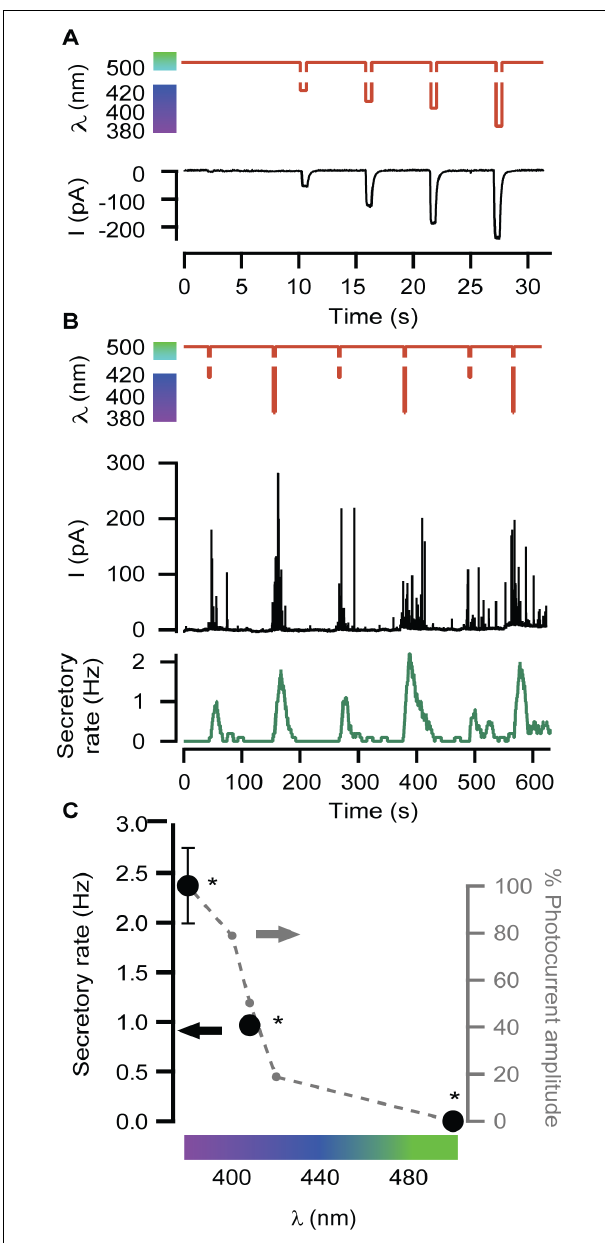
FIGURE 2 | Modulation of secretory rate. (A) LiGluR current amplitude can be adjusted with the illumination wavelength: whole-cell patch clamp current responses (black) to light pulses between 500 nm and different UV wavelengths (sequence of pulses of 420, 408, 400, and 380 nm, red plot). (B) The wavelength of light stimuli (red plot) allows adjusting the size of the burst of amperometric spikes (black plot) and thus the maximum secretory rate in each burst (green plot).The exocytosis rate always returns to 0 under 500 nm light, and can be driven reproducibly at 1 or 2 Hz by stepping to 408 or 380 nm, respectively. (C) Plot of the averaged secretory rate in • , left y -axis, N = 4 cells) response to 380, 408, and 500 nm light ( measured by amperometry. In gray, photocurrent amplitude dependence on wavelength illumination in LiGluR( + ) chromaffin cells measured by • -, right y -axis, N = 4 cells). All pairs are whole-cell voltage-clamp (- significantly different ( p = 0.12) and were compared using a non-parametric multiple comparison test (Kruskal–Wallis) and a multicompare LSD test. Error bars indicate ±